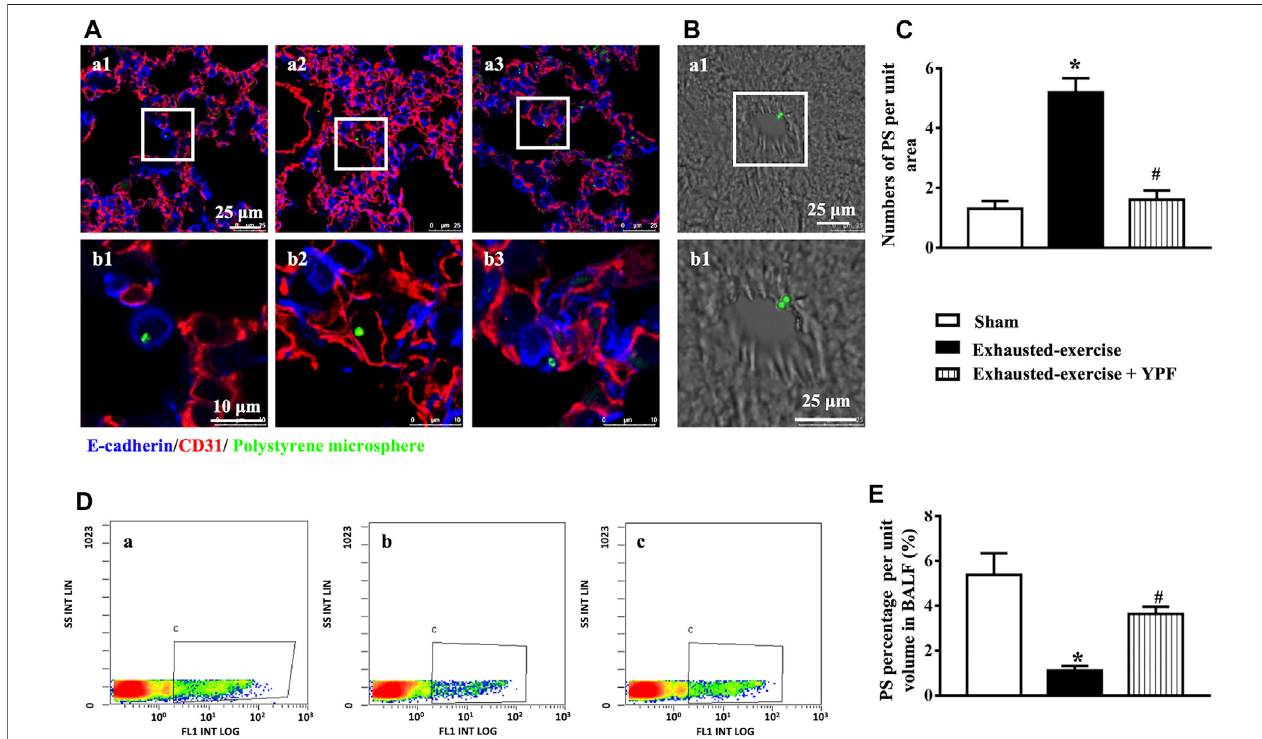
FIGURE 8 | Integrity of the alveolar-capillary barrier evaluated by intratracheal instillation of the polystyrene microsphere. (A) Representative immuno fl uorescent staining images of lung tissue. The microvessel was marked by CD31 as red and alveoli were marked by E-cadherin as blue. Green dots represent the polystyrene microsphere. (a1, b1) Sham group; (a2, b2) exhausted-exercise group; and (a3, b3) exhausted-exercise + YPF group. Upper scale bar = 25 μ M; lower scale bar = 10 μ M. (B) Light fi eld of liver tissue. Green dots represent the polystyrene microsphere. (a1, b1) Exhausted-exercise group. Scale bar = 25 μ M. (C) Number of polystyrene microspheres per unit area in liver tissue sections. Results are presented as means ± SEM ( n = 3). (D) Representative image of fl ow cytometry. (a) Sham group; (b) exhausted-exercise group; and (c) exhausted-exercise + YPF group. (E) Percentage ofpolystyrene microspheres per volume in BALF. Results are presented as means ± SEM ( n = 4). * p < 0.05 vs. sham; # p < 0.05 vs.